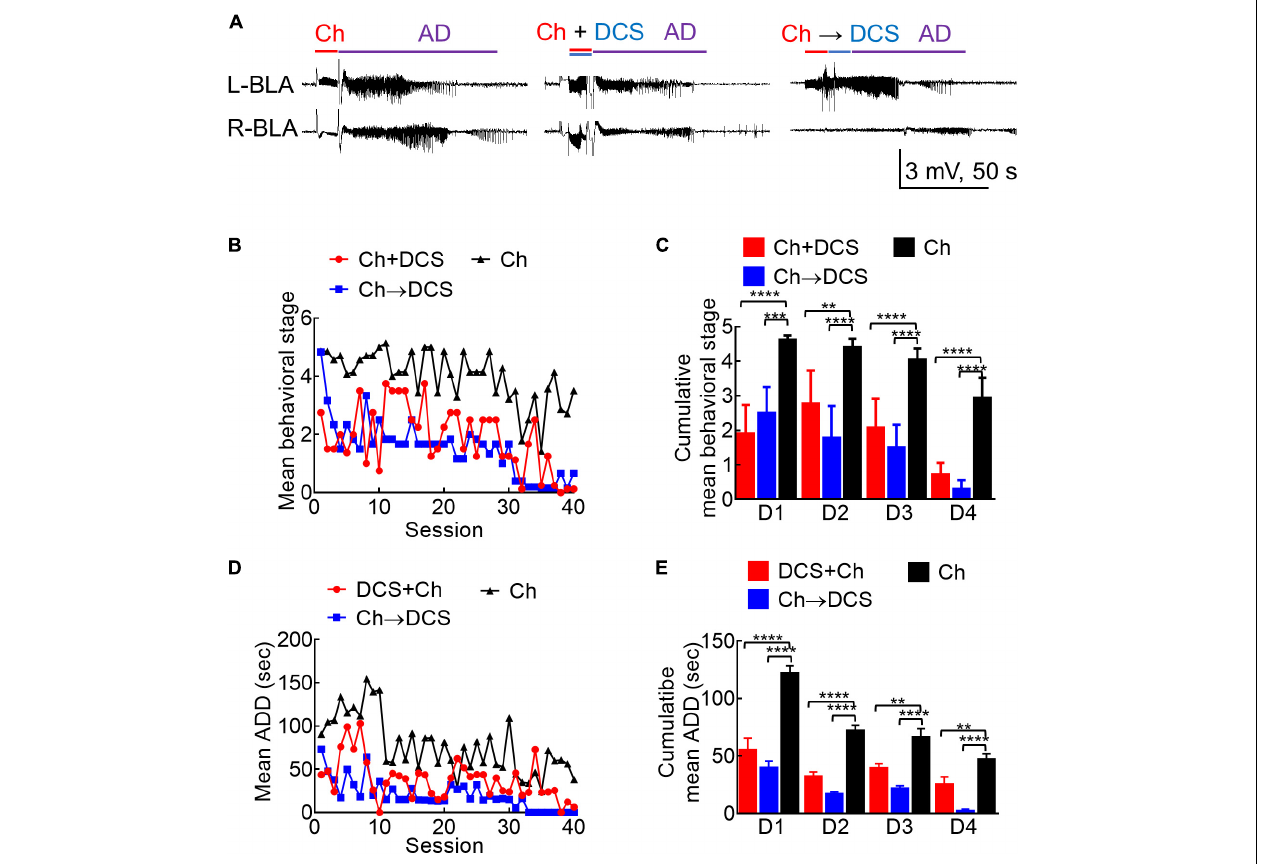
FIGURE 3 | The anticonvulsant effect of DCS given with or immediately after the challenge stimuli in fully kindled rats. (A) Sample LFP recordings (left panel) show AD elicited with a challenge stimulus in the left basolateral amygdala (L-BLA) in a fully kindled rat. Behaviorally, this would usually cause Racine stage 5 seizures as in this case, 100 µ A, 10 s in situ direct current stimulation (DCS) was given concomitantly with (DCS + Ch, middle panel) or immediately after (Ch → DCS, right panel) the challenge stimulus (Ch) in the fully kindled rat. The values of AD are slightly shortened in both DCS conditions (with behavioral stages attenuated to stage 3 and stage 4, respectively). (B) The mean behavioral stage at each of the 40 challenge stimulation sessions with DCS given concomitantly with or immediately after the challenge (Ch + DCS, red symbols, n = 4; Ch → DCS, blue symbols, n = 6) is in general, lower than that with challenge only (Ch, black symbols, n = 7). Only the mean values are shown [SEM is omitted for the sake of clarity]. (C) The cumulative mean behavioral stage in each of the 4 days is lower in both DCS groups if compared to the challenge only group ( n = 10, 10, 10 each day from the mean of 4, 6, 7 rats for Ch + DCS, Ch → DCS, and Ch group, respectively). (D) The mean AD duration (ADD) from L-BLA after each challenge stimulation is shortened by DCS given with or after the challenge (DCS + Ch, red symbols, n = 4; Ch → DCS, blue symbols, n = 5; Ch, black symbols, n = 3). (E) The cumulative mean ADD in each of the 4 days is lower in both DCS groups if compared to the challenge